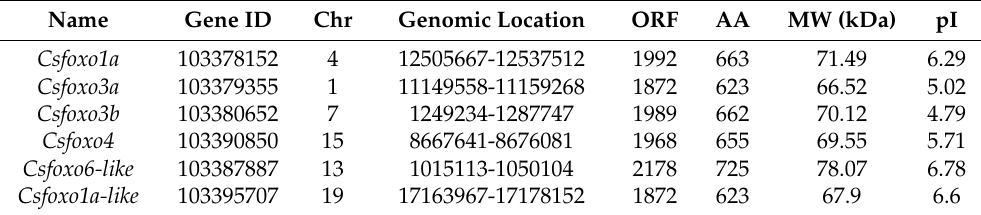
Table 1. Abbreviations used in this table: Chr, chromosome; ORF, open reading frame; AA, amino acid; MW, protein molecular weight; pI, isoelectric